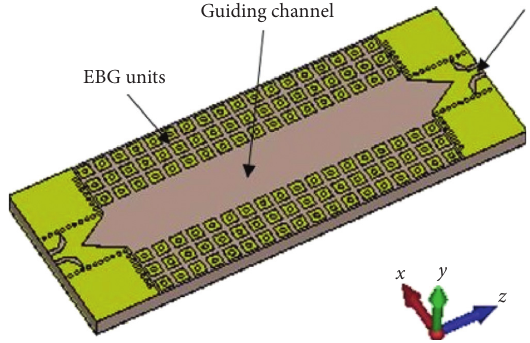
Figure 1: EBG-based dielectric